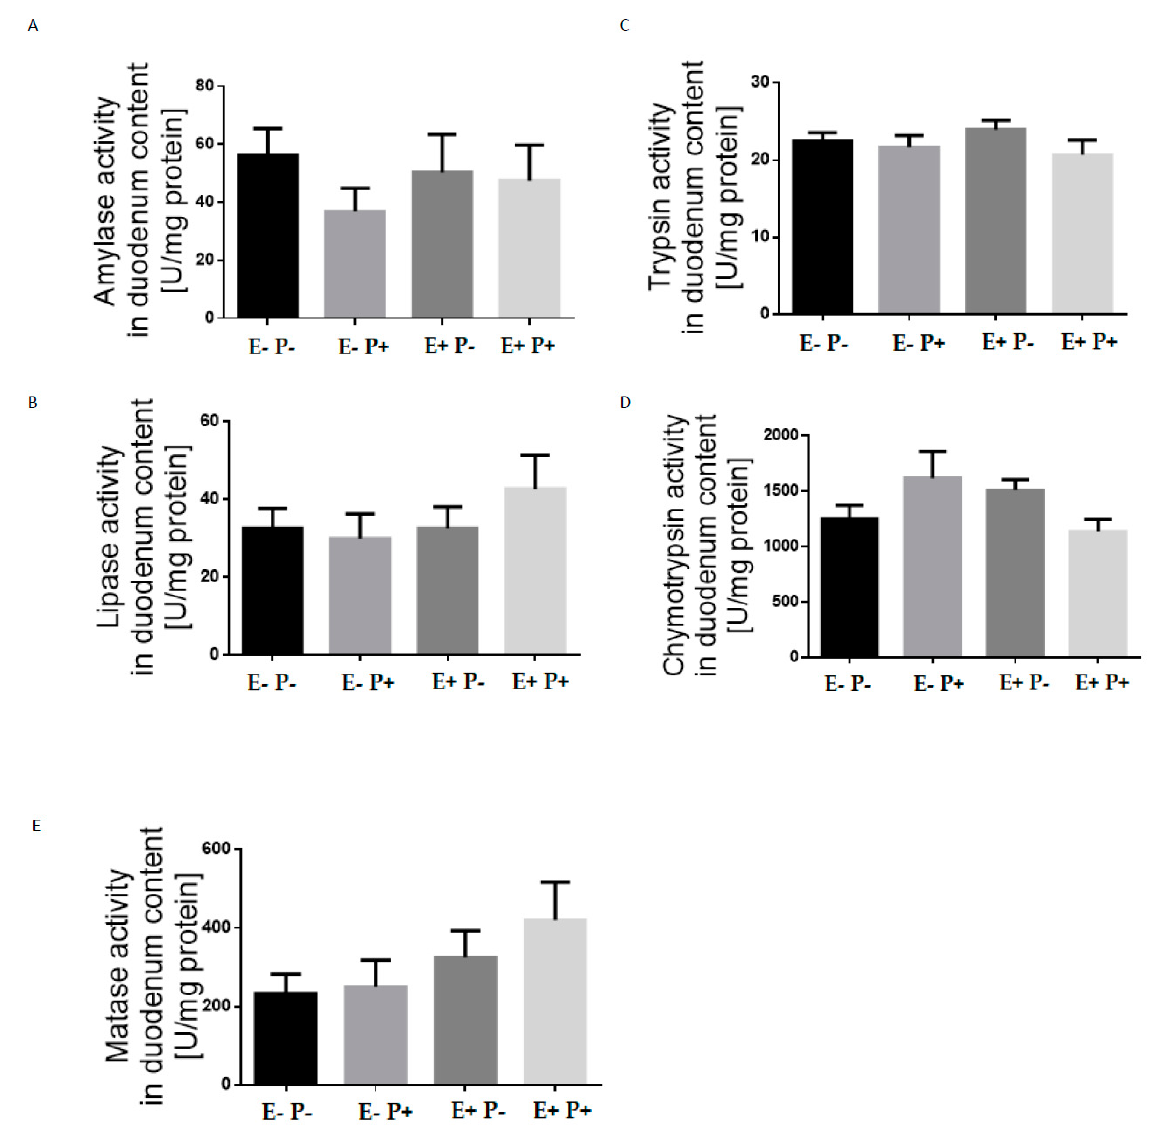
Figure 1. Enzyme activity (U/mg protein) in the pigs’ duodenum ( n = 8). The effect of extrusion treatment and protease supplementation on amylase ( A ), lipase ( B ), trypsin ( C ), chymotrypsin ( D ), and maltase ( E ) activity in the duodenum content. The results are expressed as mean ± S.E.M.; ‘‘E − ’’—no treatment; “P − “—no enzyme supplementation; ‘‘E+’’—treatment; “P+”–enzyme sup- plementation. Table 7. The morphometric parameters of the pigs’ ileum ( n = 8).